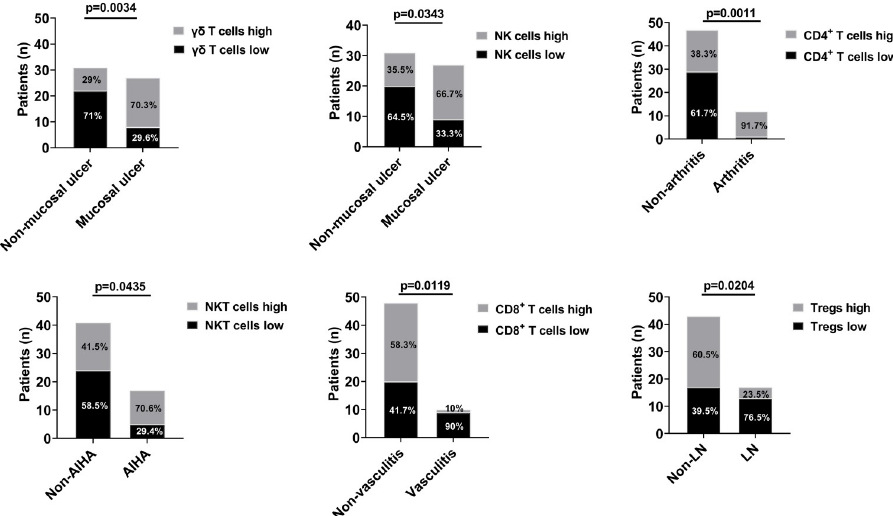
Fig 3. Associations between lymphocyte subsets and clinical manifestations in juvenile-onset systemic lupus erythematosus. Data are presented as number of patients (Y-axis) and the presence of each clinical presentation (X- axis). Patients were stratified into 2 groups based on the median percentage of each subset. Percentage of patients are presented (stacked bar chart) as high (light color) and low groups (dark color). n, number of patients; Tregs,